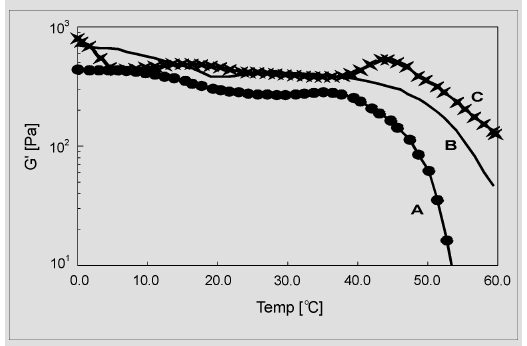
Figure 1: Temperature dependence of G’ for A, B and C body lotions at 10 rad/s and 4°C/min from 0